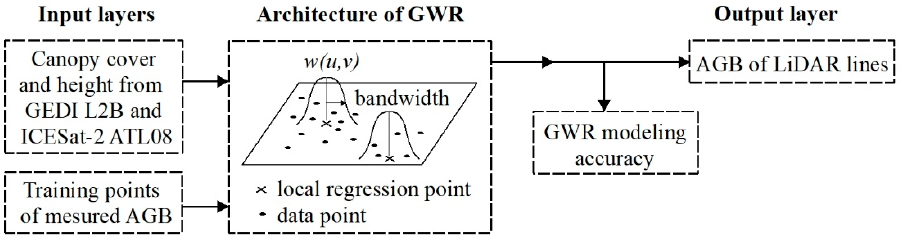
Figure 3. Illustration of AGB estimation from LiDAR lines by geographically weighted regression (GWR) modeling. W(u, v), a weight matrix, ensures measurements obeying a distance decay.